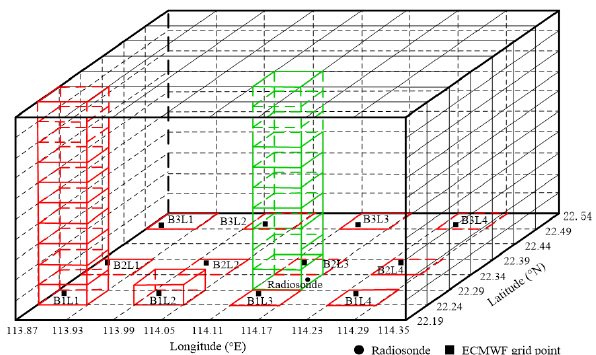
Figure 1. Schematic of the improved method for building the unit scale factor